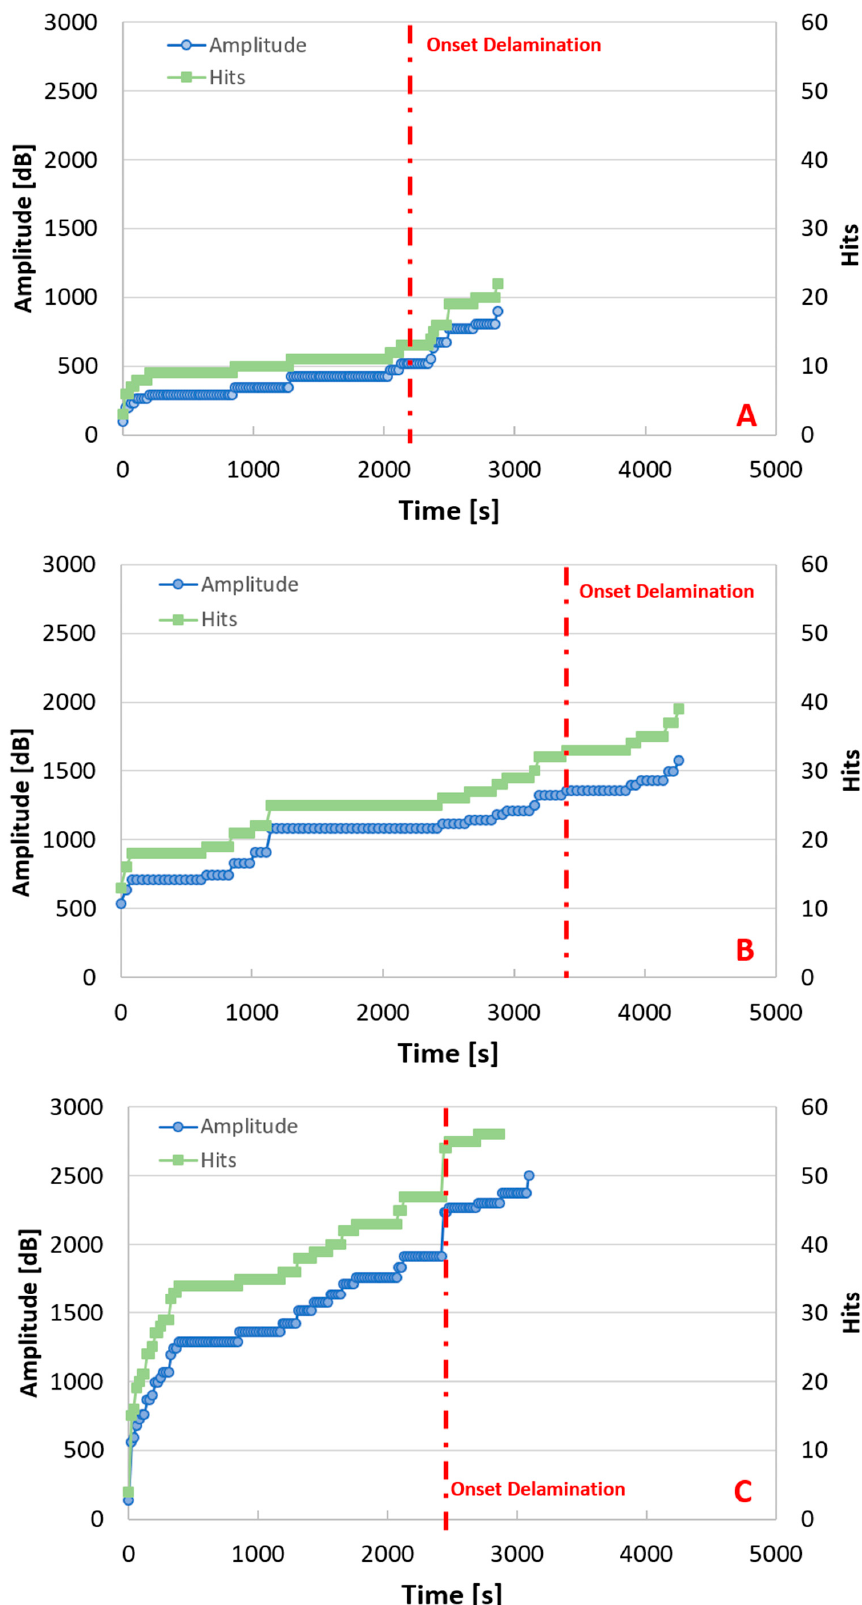
Figure 7. Acoustic emissions recorded: ( A ) refers to Group A specimen (220 ◦ C); ( B ) refers to Group B specimen (230 ◦ C); ( C ) refers to Group C specimen (240 ◦